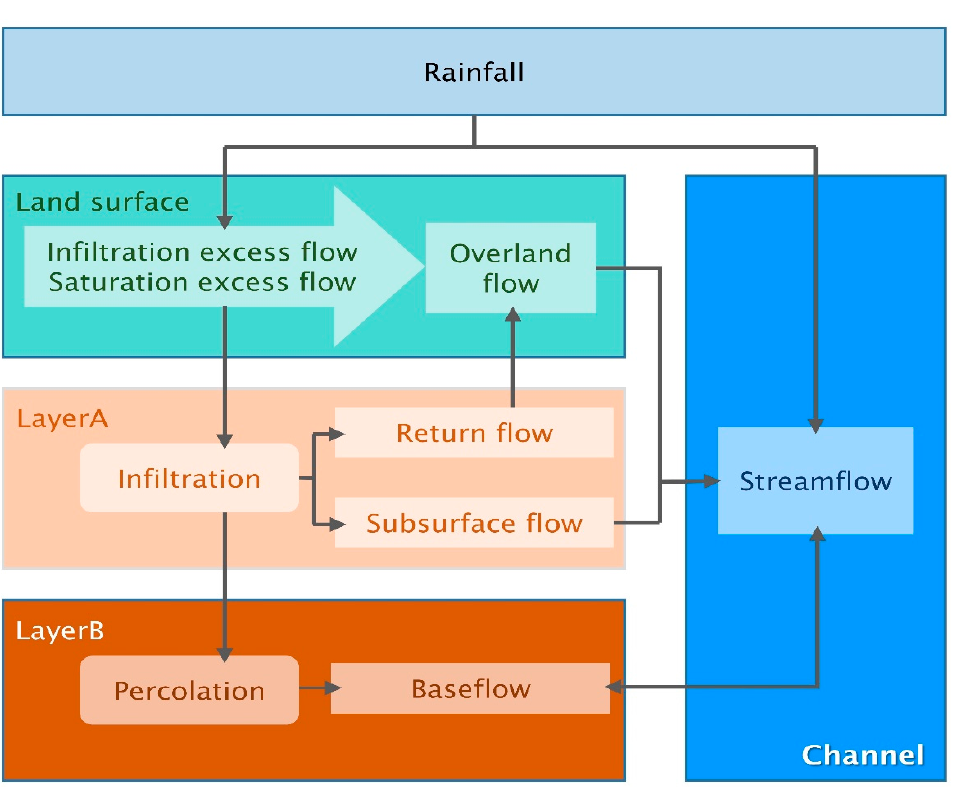
Figure 2. Schematic of the grid-based rainfall-runoff model